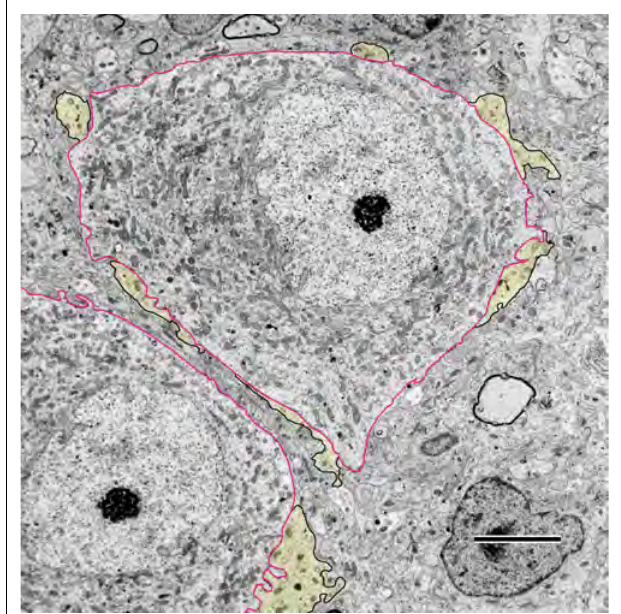
FIGURE 2 | Low magnifi cation electron micrograph through the anteroventral cochlear nucleus (AVCN) of a newborn deaf white kitten. The cell body of spherical bushy cells (SBCs, outlined in red) is contacted by endbulbs of Held (yellow with black outlines). The segments of membrane contact between the two cells are irregular and “wavy” in appearance. Some lightly myelinated axons are visible in the AVCN at this age. Scale bar equals 5